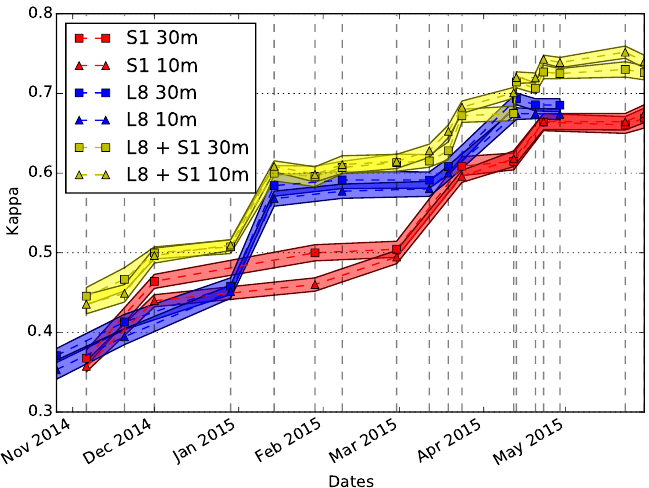
Figure 6. Comparison of classification accuracy between data resampled to 30 m and data resampled to 10 m.